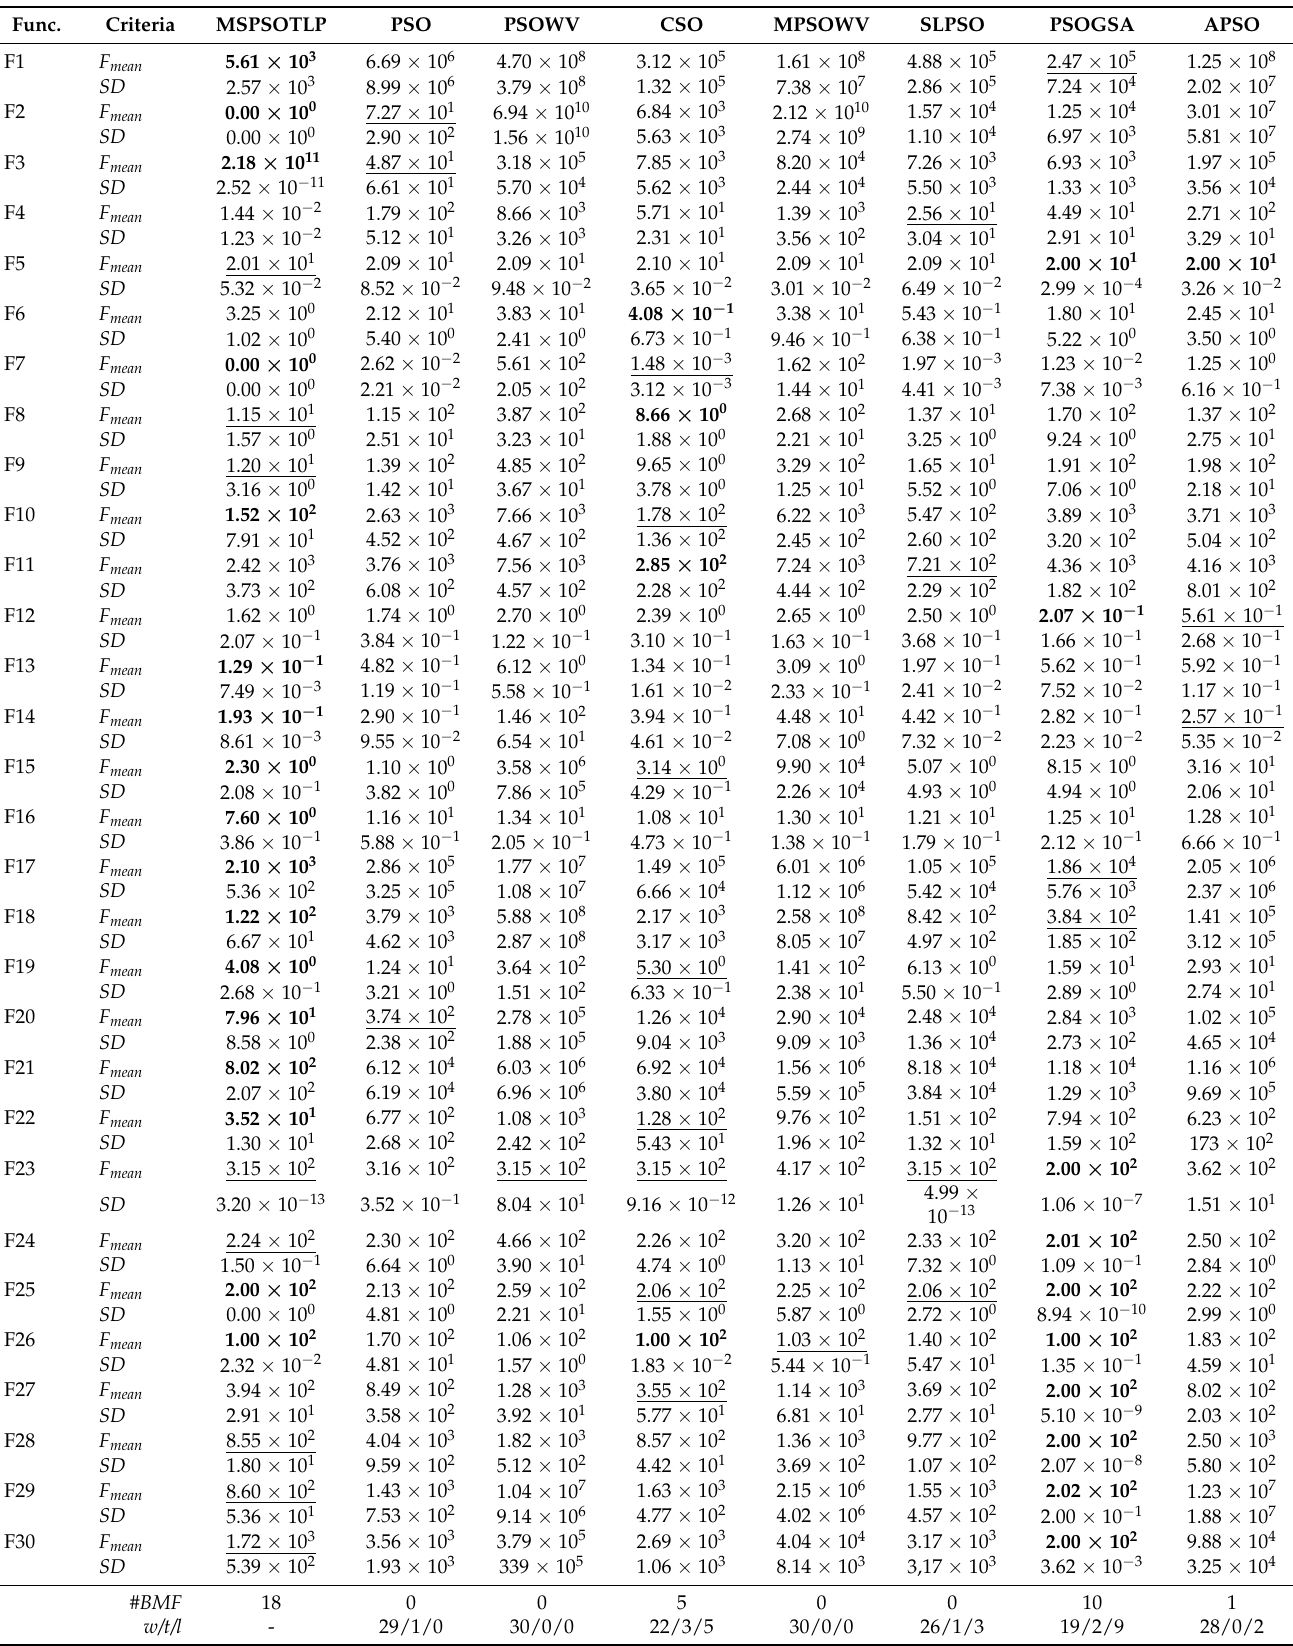
Table 5. F mean and SD values produced by the proposed MSPSOTLP and other PSO variants in solving CEC 2014 benchmark